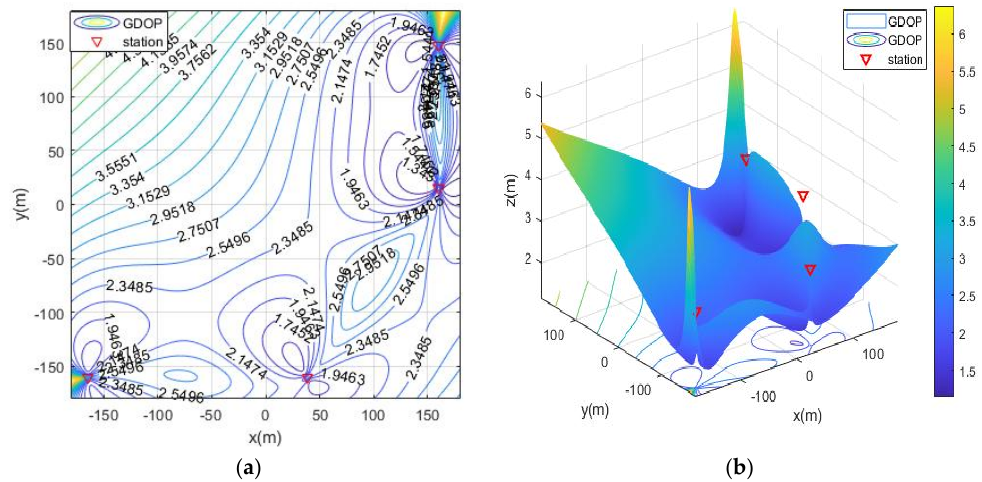
Figure 9. GDOP contour map of optimization results with 4 base stations located on vertical adjacent sides of the positioning area. ( a ) 2D contour map of moa03; ( b ) 3D contour map of moa03.